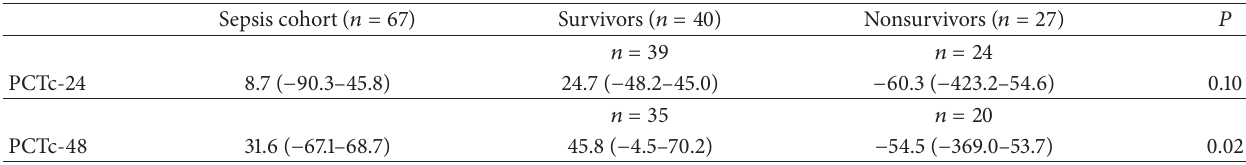
Table 3: PCT clearance in survivors and nonsurvivors.